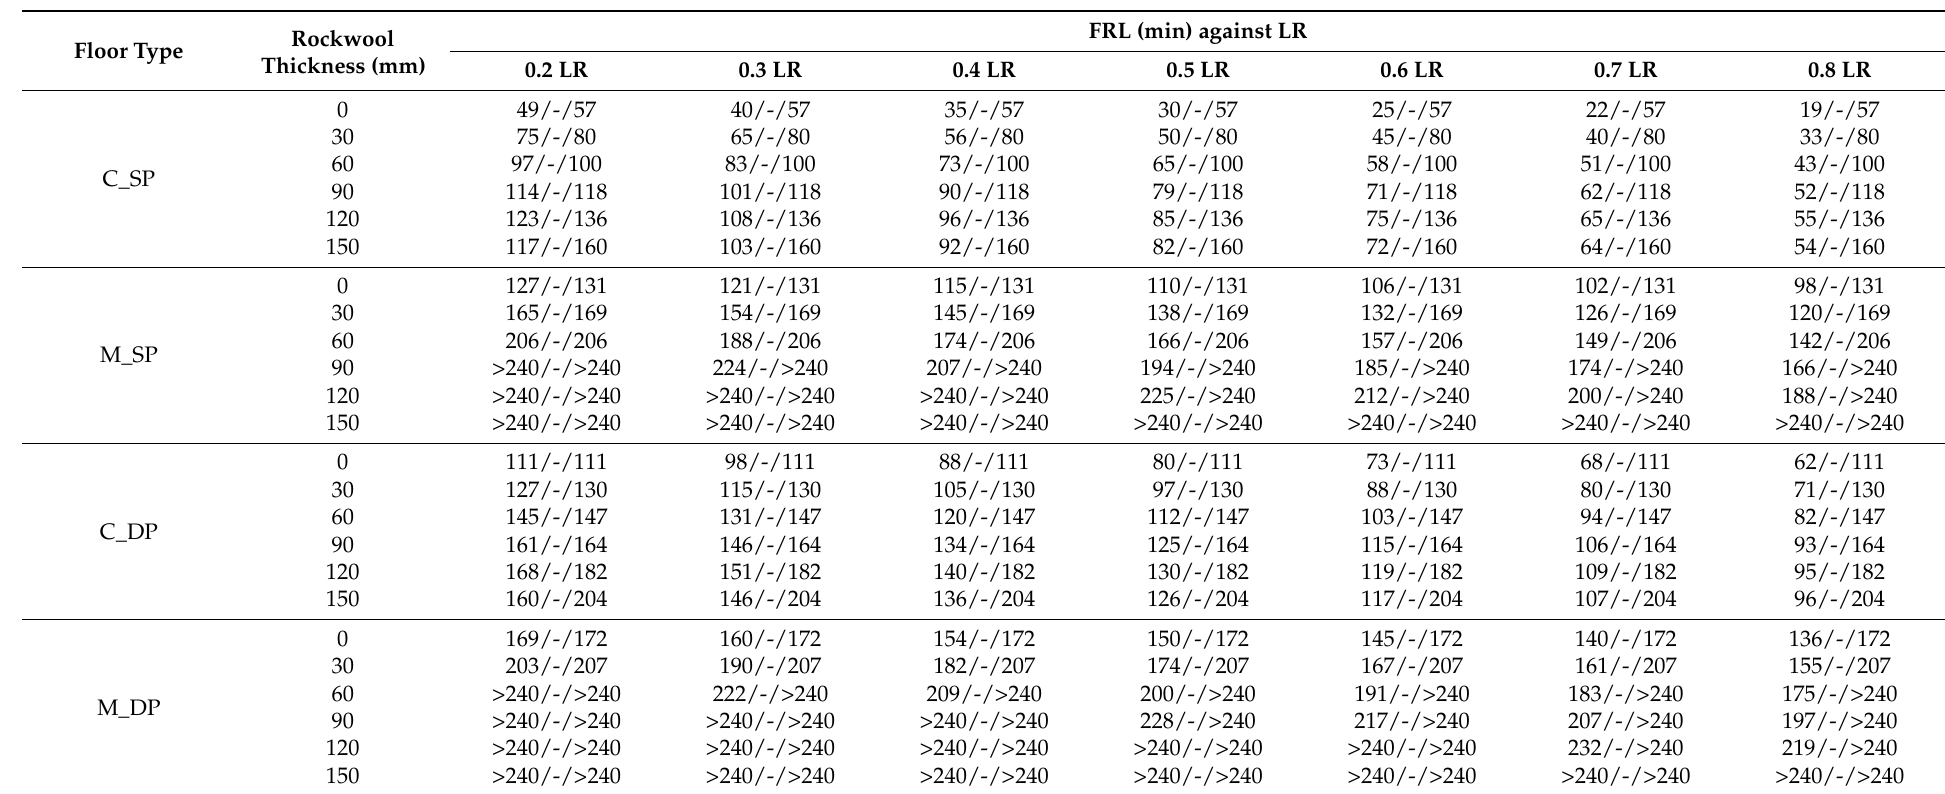
Table 3. Exact FLRs of parametric floor systems evaluated from